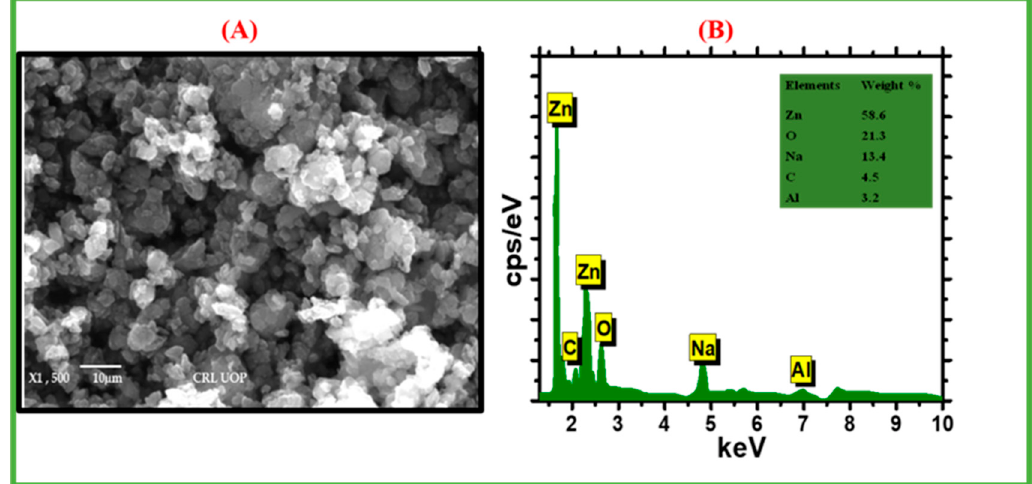
Figure 3. SEM and EDX images of green-synthesized zinc oxide NPs. ( A ) SEM image; ( B ) EDX